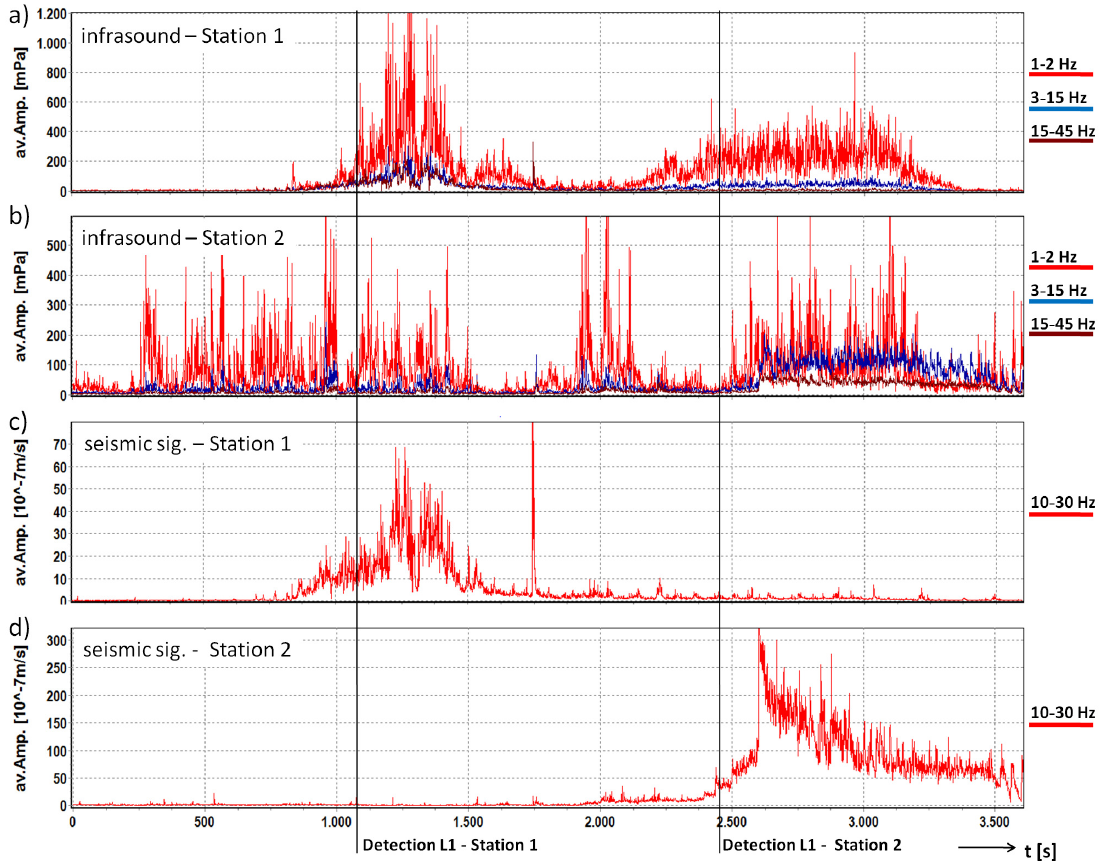
Figure 8. Comparison of the Infrasound and seismic data from the debris flow on 22 July 2015 at Stations 1 and 2 in the Illgraben catchment. Signals are represented with a common base of time. ( a ) average amplitude of the three frequency bands of the infrasound signal at Station 1; ( b ) average amplitude of the three frequency bands of the infrasound signal at Station 2; ( c ) average amplitude of the frequency band of the seismic signal at Station 1; ( d ) average amplitude of the frequency band of the seismic signal at Station 2; lines: time of first detection for Level 1 at Stations 1 and